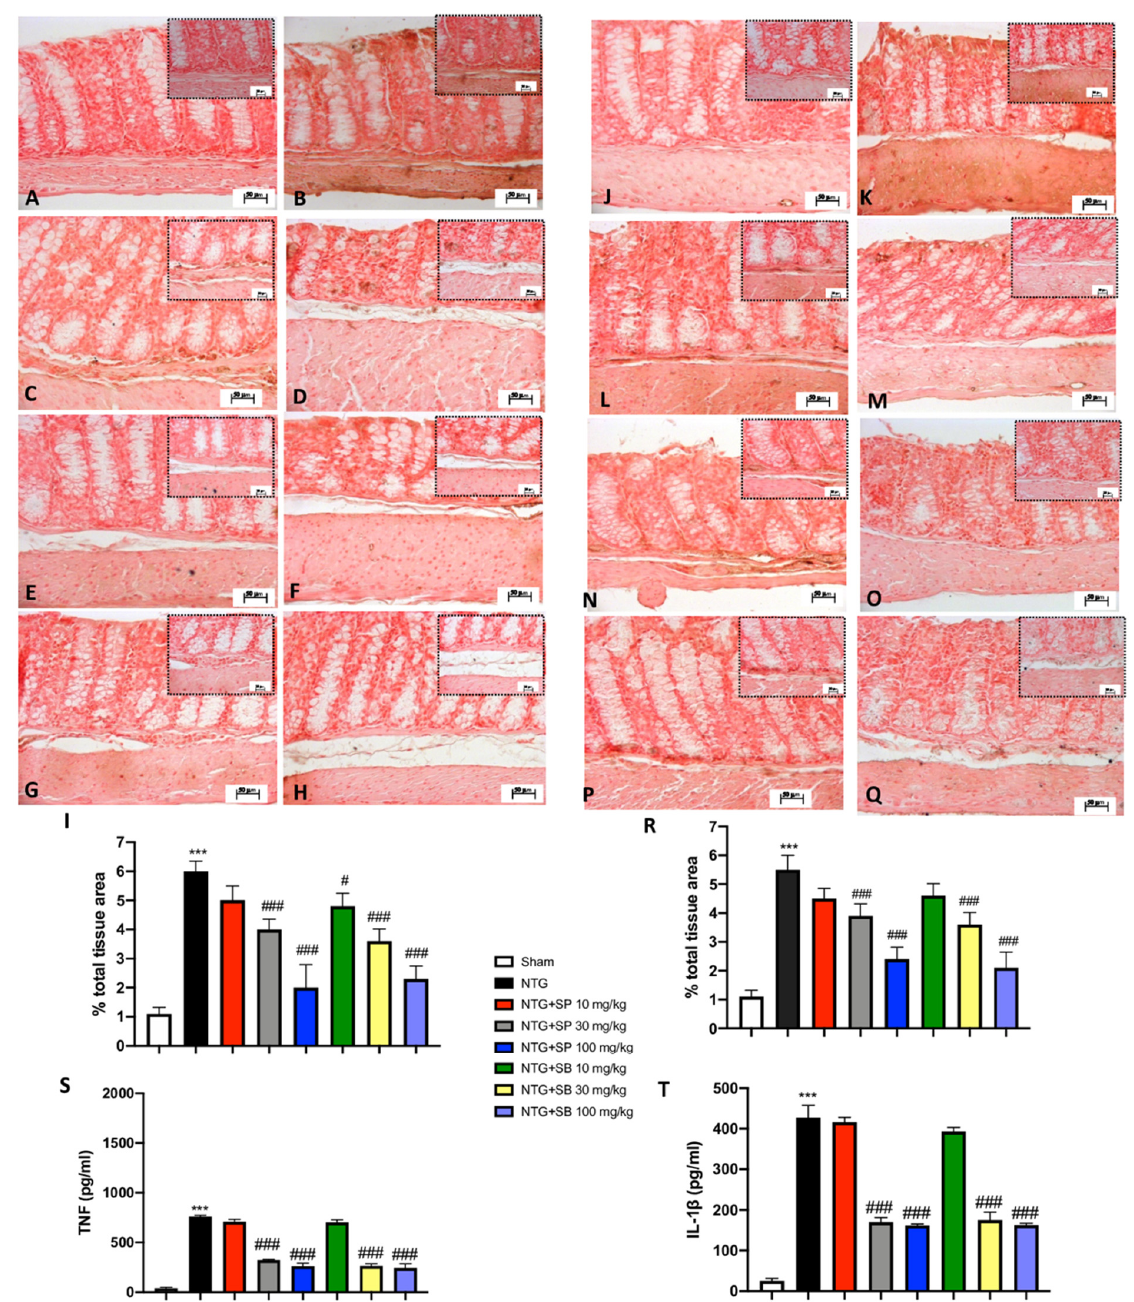
the control mice (Figure 5K,J, respectively). A decrease of IL-1 β immunoreactivity was attributed to the beneficial effect of higher doses of SCFAs (30 mg/kg and 100 mg/kg) (Fig- SP; Figure 5P,Q for SB), maintaining intestinal integrity following NTG-induced migraine. ure 5M,N for SP; Figure5P,Q for SB), maintaining intestinal integrity following NTG-in- These results were confirmed by the ELISA kit (Figure 5S,T, respectively). duced migraine. These results were confirmed by the ELISA kit (Figure 5S,T, respectively).